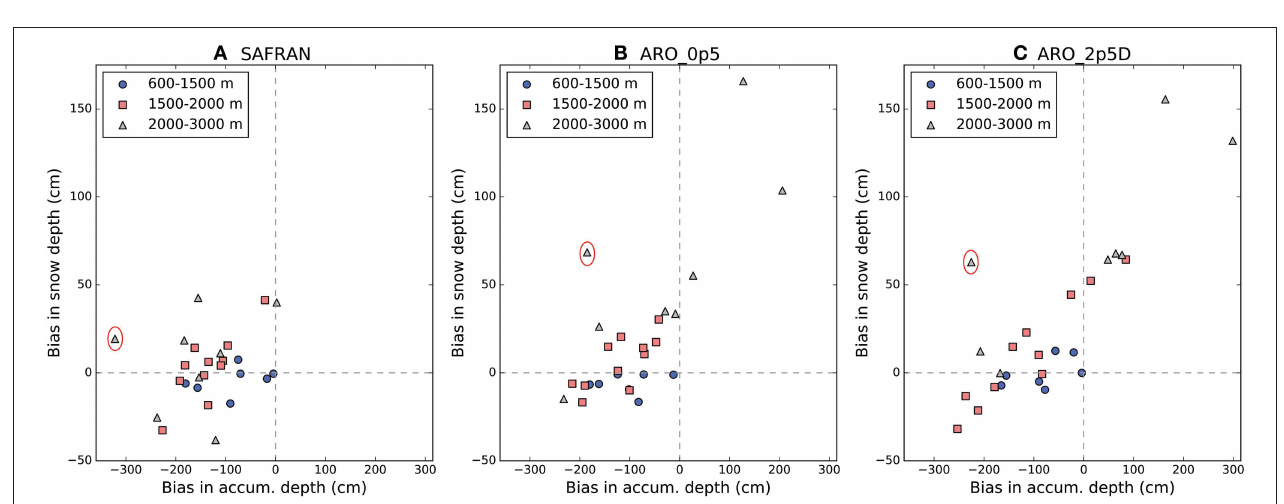
FIGURE 8 | Comparison of measured and simulated cumulative sum of positive daily snow depth variation at the end of the season for 26 stations. Results of three Crocus simulations are considered: (A) SAFRAN , (B) ARO_0p5 , and (C) ARO_2p5D . On each graph, the dashed line represents the line y = x and different symbols are used as a function of the stations elevation. Error statistics (Bias, RMSE, and coefficient of determination, R 2 ) are given for each simulation.